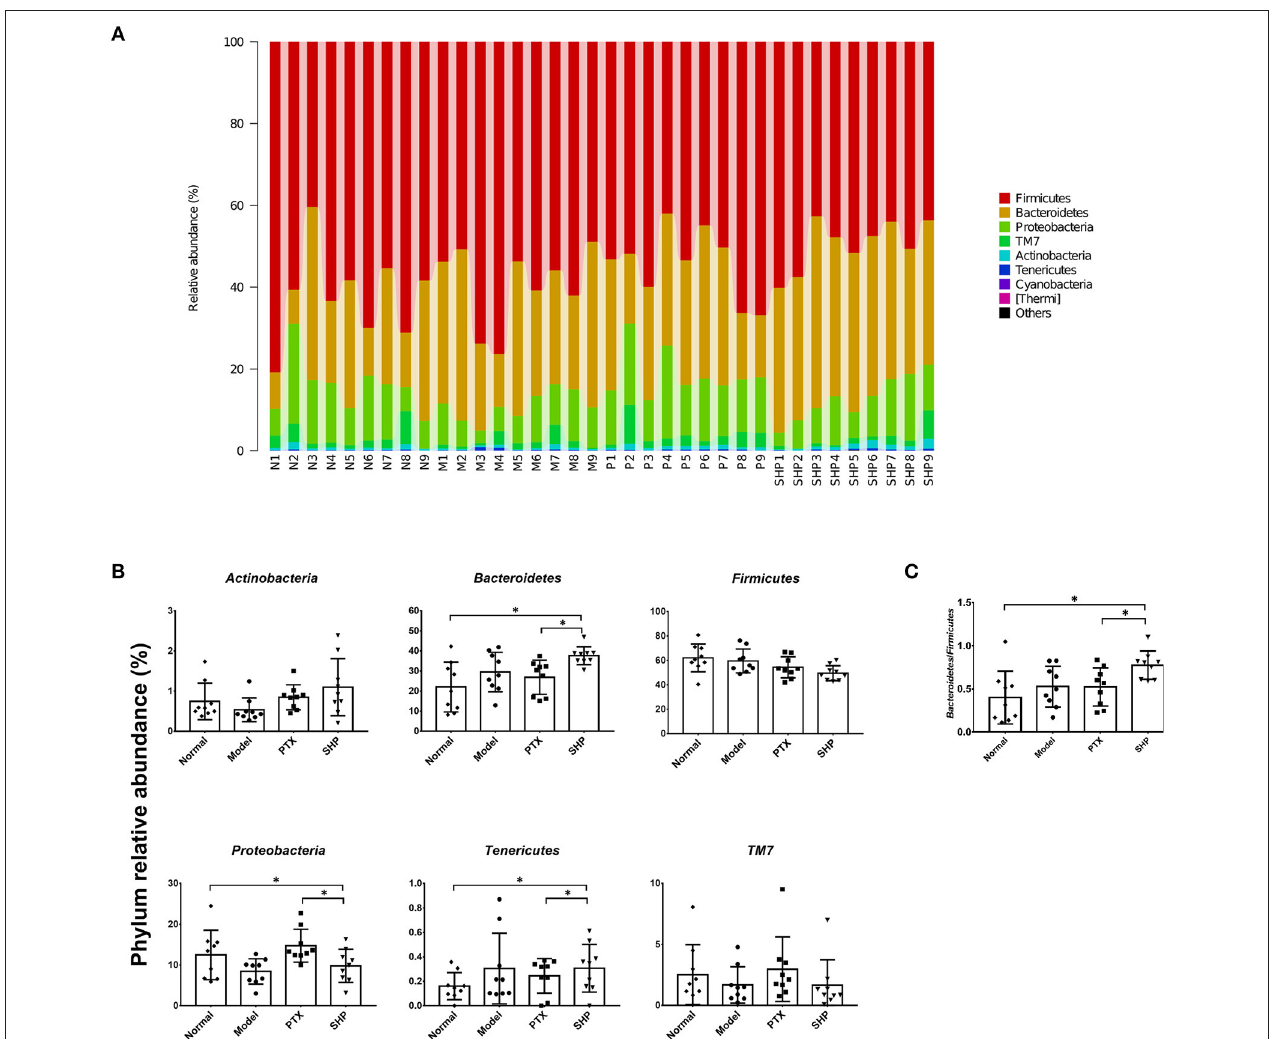
FIGURE 5 | Taxonomy analysis of microbiota in the cecum content at phylum level. (A) Identified phyla in each sample. (B) Phylum relative abundance comparison (0.1%). (C) Ratio of Bacteroidetes to Firmicutes . Values were represented the means ± SD. * p <